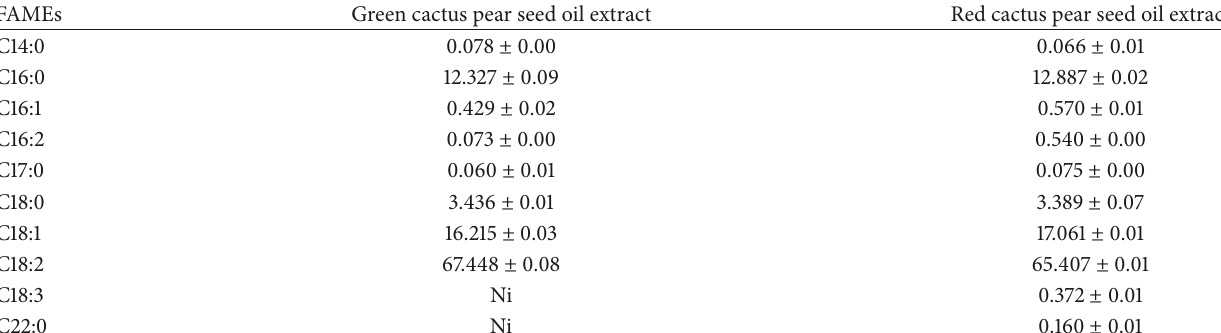
Table 2: Percentages of FAMEs in crude cactus pear seed oil extracts.